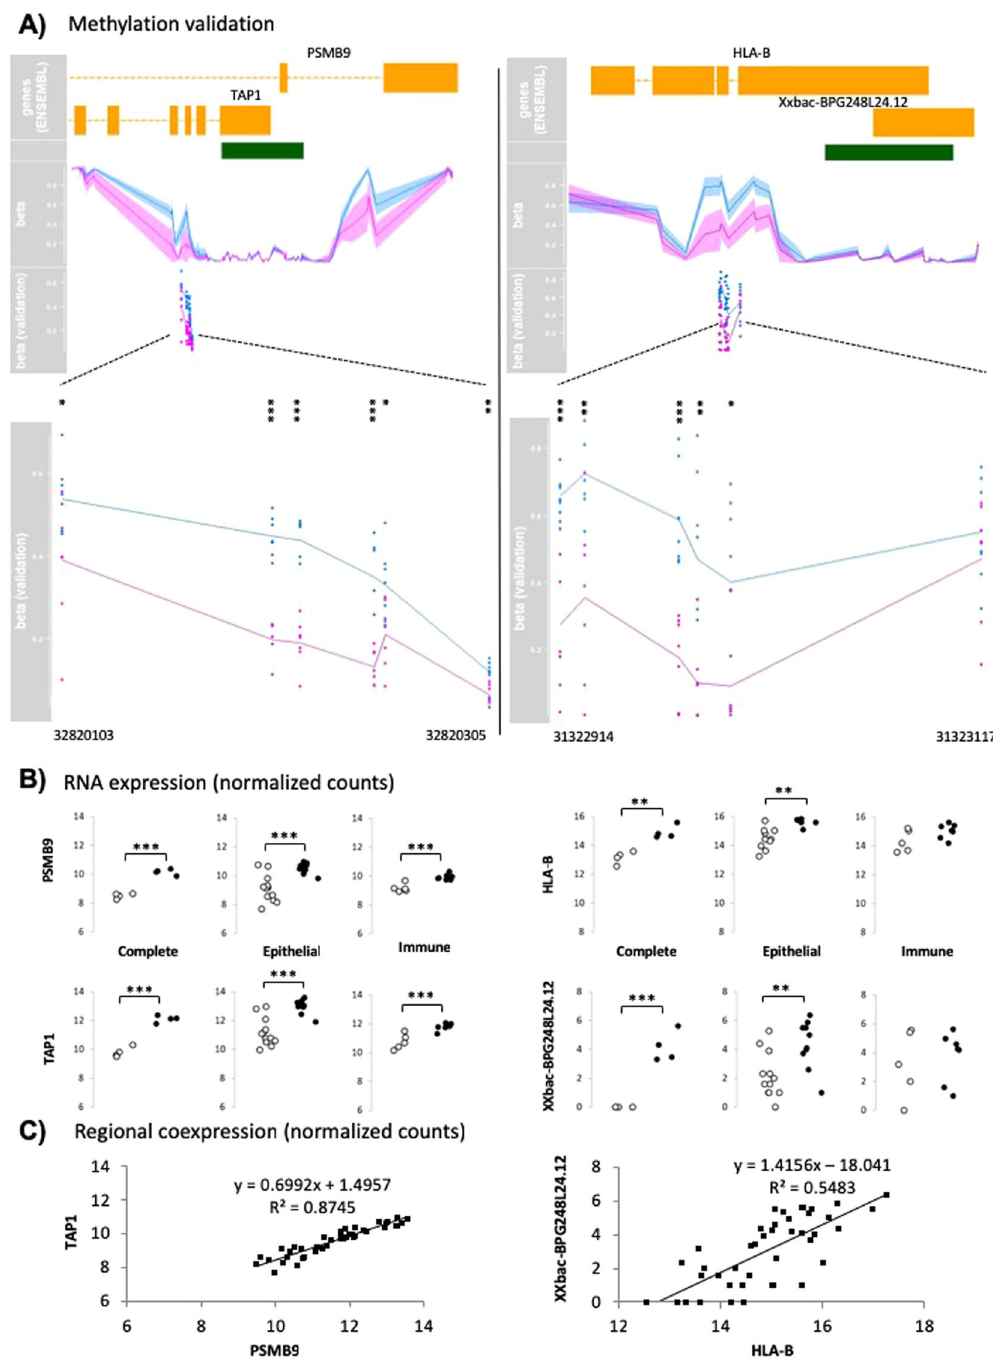
Figure 5. Validation of the TAP1 and HLA-B overlapping DMRs by direct bisulfite sequencing and expression analysis. ( A ) Genomic context and methylation patterns of CD patients (purple) and control individuals (blue) in each DMR. Methylation levels extracted from the methylation array are represented in the upper panel, while those obtained after direct bisulfite sequencing appear below and are referred to as “betas (validation)”. Green boxes represent CGIs. * , ** and *** represent p values < 0.05, 0.01 and 0.001 (unpaired T-test), respectively. ( B ) Expression patterns of the DMR-overlapping genes in the different cell compartments. Grey and black dots represent control and CD patients, respectively. ( C ) Coexpression of the regional